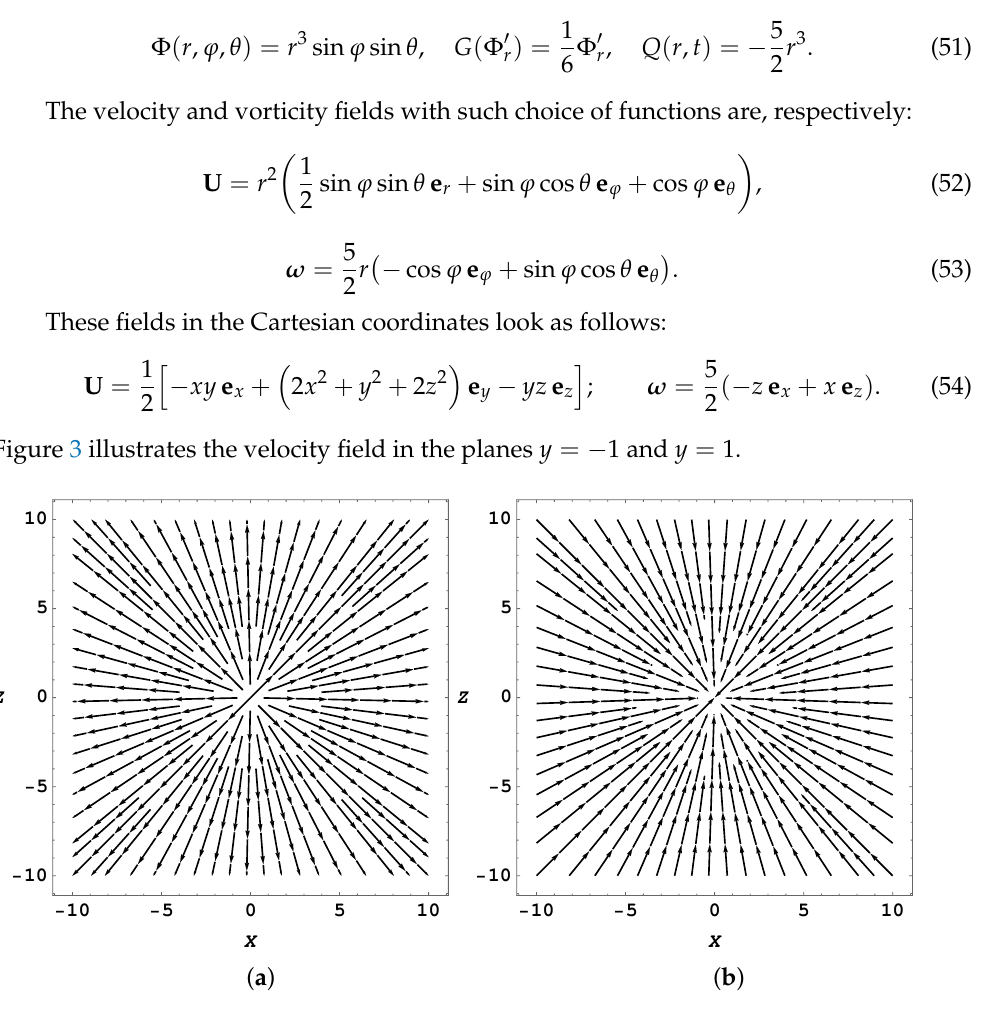
Figure 3. The velocity field in the planes y = − 1 ( a ) and y = 1 ( b ) as per Equation (54). Figure 4 illustrates the velocity field in the planes x = 0 and x = ± 5, and Figure 5 illustrates the vorticity field in the ( x , z )